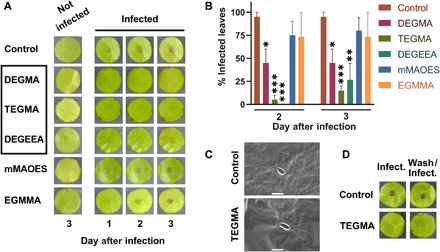
Protection against fungal infection of plant leaves.Polymers were synthesized via free-radical polymerization using a thiol chain transfer agent; see table S4 for percentage conversion, molecular weight (Mn), and polydispersity (Đ). (A) Materials prepared at 20% (w/v) [using 20% (v/v) isopropanol solvent] were sprayed onto 1.5-cm-diameter lettuce leaf discs, before infection (right) or no infection (left) with B. cinerea (2500 spores per disc). Infection was examined daily up to 3 days (leaves deteriorated subsequently). The box highlights polymers giving the best protection from infection. Images are representative of three or more independent experiments, each with five leaves infected. (B) Percentages of infected leaves (no infection was observed at day 1). Values are means ± SEM. *P ≤ 0.05, **P ≤ 0.01, and ***P ≤ 0.001 according to Dunnett’s multiple comparisons by two-way ANOVA. EGMMA served as positive control. Growth assays confirmed no B. cinerea toxicity with these polymer preparations. (C) Scanning electron microscopy images of TEGMA-coated (bottom) or uncoated (top) leaf surfaces (×1000 magnification). Scale bars, 20 μm. ToF-SIMS analysis is in fig. S6. (D) TEGMA-coated leaf discs were washed with water or not before infection as in (A). Images taken at day 3, representative of five leaves infected per condition. Photo credits: Cindy Vallieres, University of Nottingham.